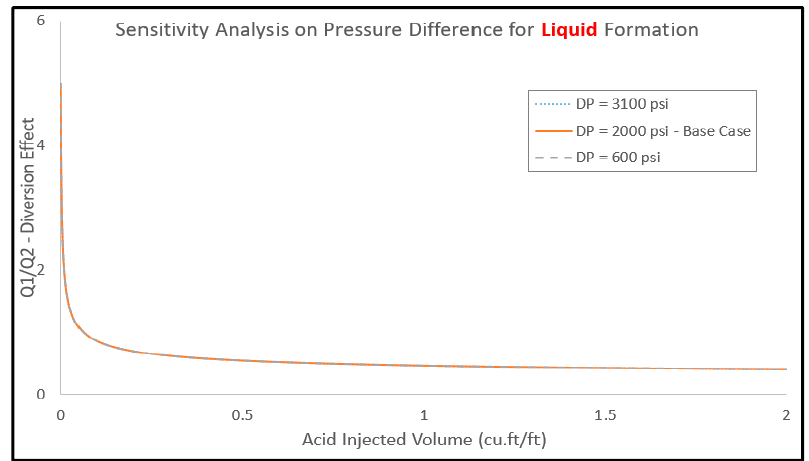
Figure 15. Effect of pressure difference (between layers 1 and 2) on the acid diversion performance. Figure 15. E ff ect of pressure di ff erence (between layers 1 and 2) on the acid diversion performance.